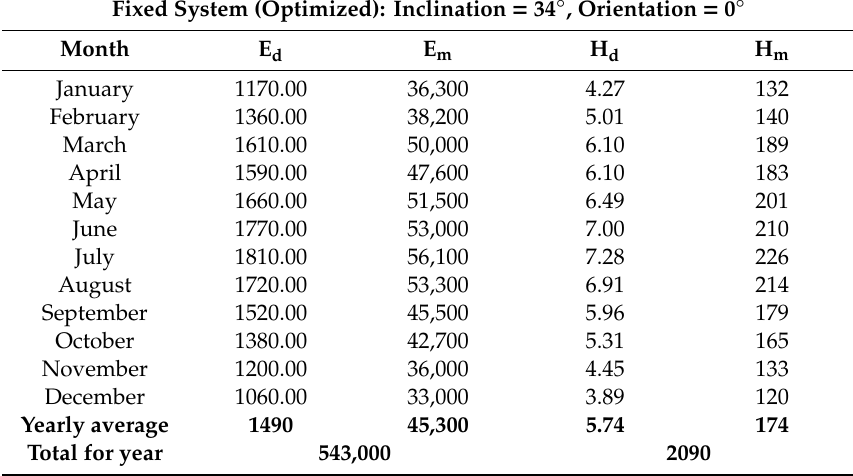
Table 3. Optimization details of the solar panels according to their position, inclination and